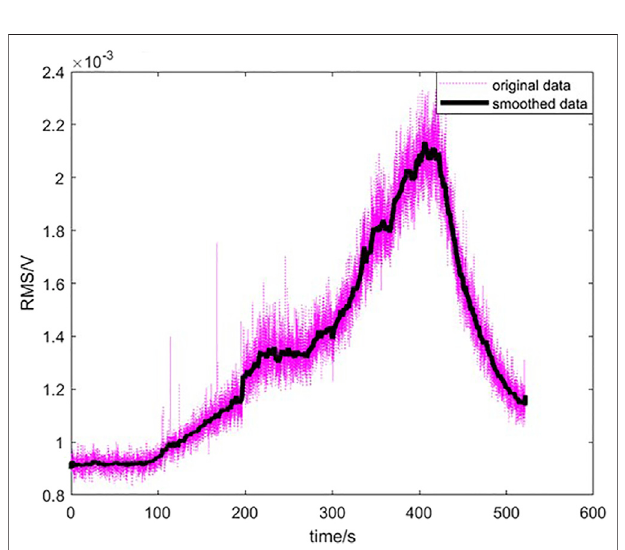
FIGURE 6 | Selection of points for power spectrum analysis.